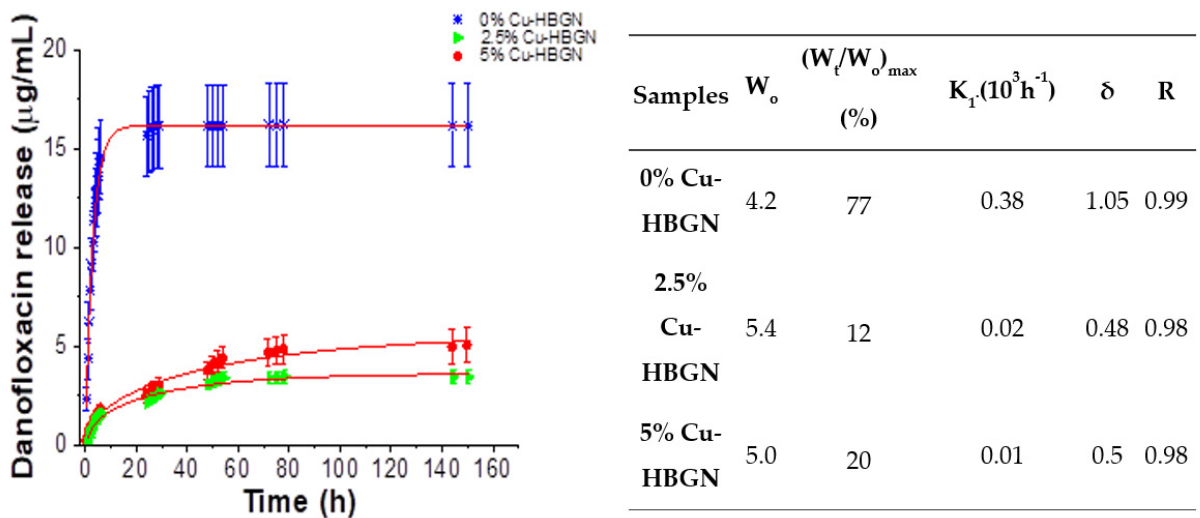
Figure 4. Cumulative release of danofloxacin from HBGN up to 6 d soaked in PBS and parameters of danofloxacin release kinetics from nanoparticles. Wo: initial loaded mass (% of antibiotic loaded); (W t /W o ) max : maximum relative release; K 1 : constant of Chapman model release rate; δ : non-ideality factor in Chapman model and R: goodness of fit.